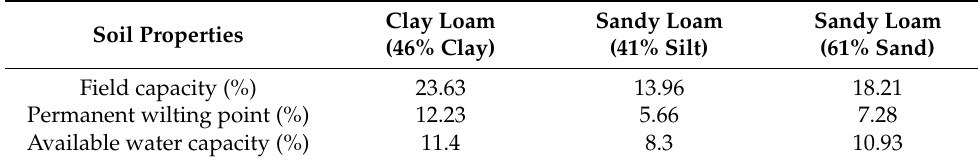
Table 3. Physical properties of selected soil types.